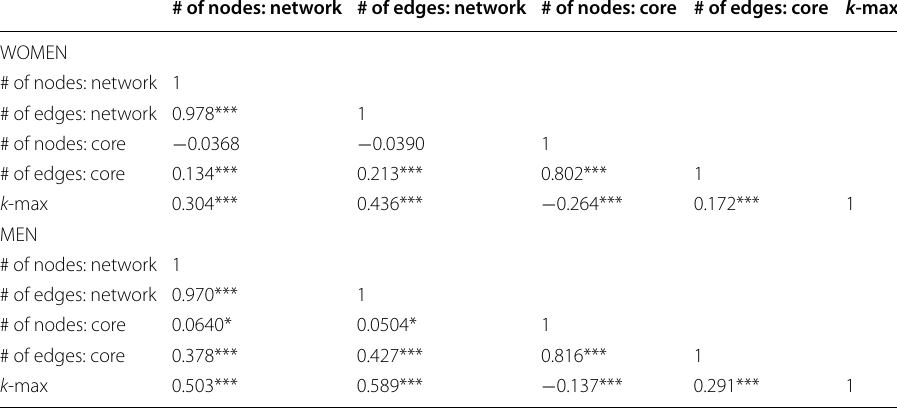
Table 5 Correlation matrix of nodes, edges and k ‑max